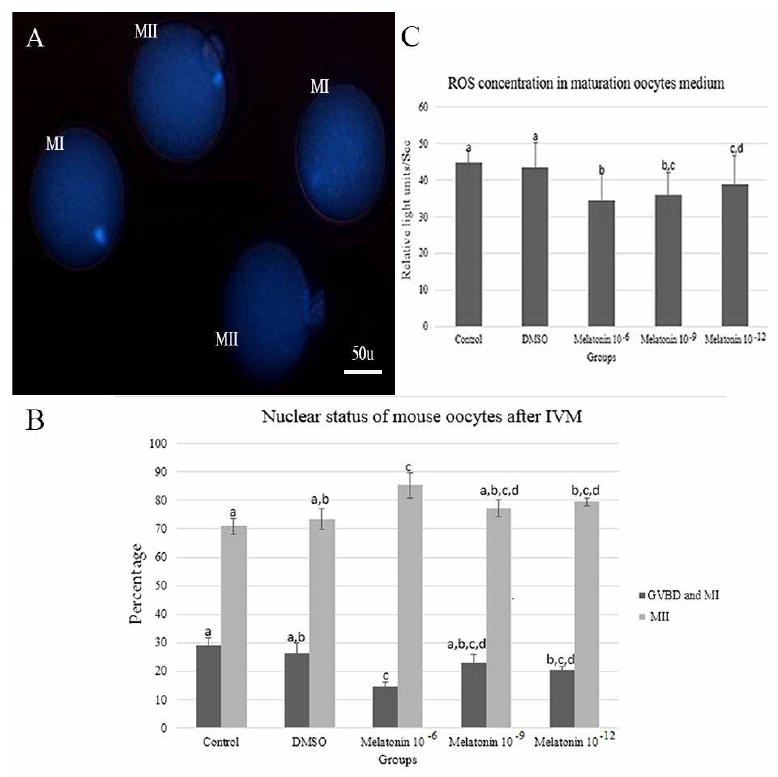
FIGURE 1 – The maturation rate of the oocytes and ROS concentration in culture media: (A) ; The fluorescent intensity of Hoechst H33342 stained nuclear mice oocytes after maturation; immature oocytes shown by MI and mature oocytes shown by MII, scale bar 50 µ (B); the chart of oocytes maturation (MII) in IVM media containing different doses of melatonin (10 -6 , 10 -9 , 10 -12 M) (C); the chart of the ROS concentration in the maturation medium after IVM. The means of MI and MII oocytes were compared by using the non-parametric analysis test (Kruskal-Wallis). a,b.c Columns with different lowercase letters differ significantly (P<0.05). Data were presented as mean ±